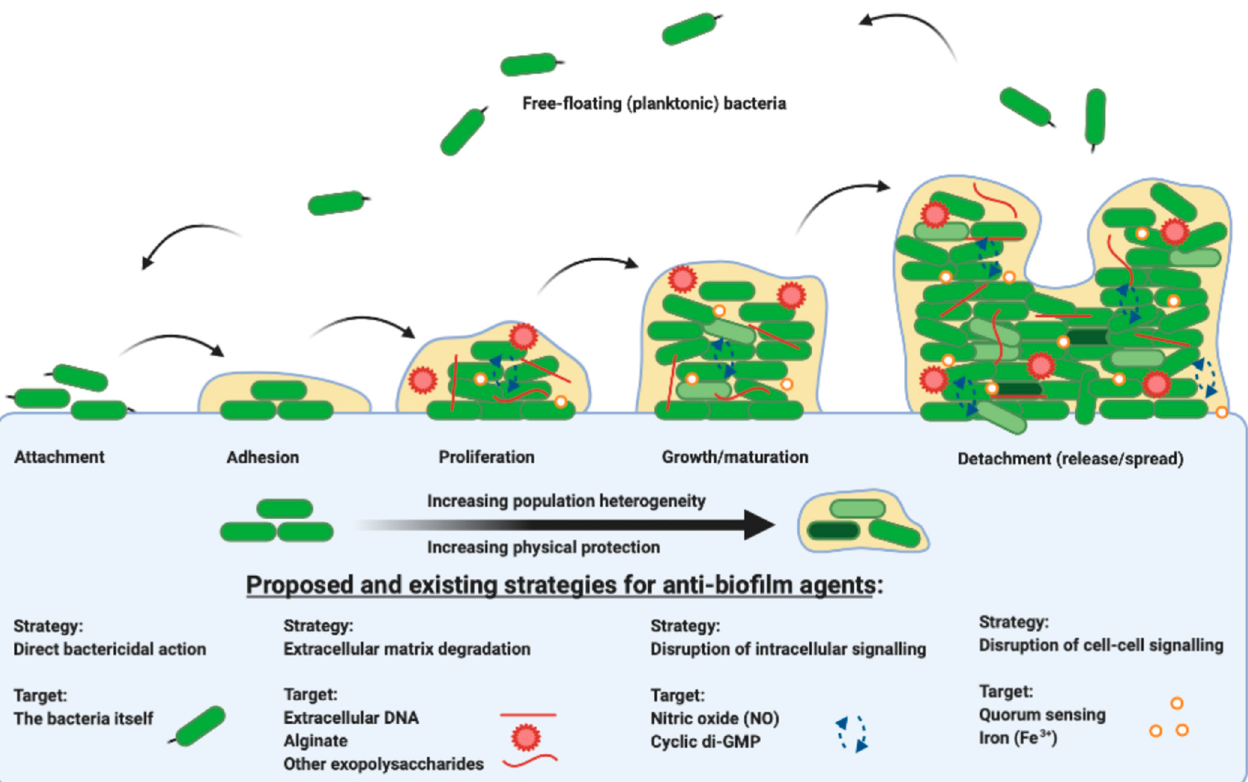
Figure 1. A representation of the bacterial biofilm life cycle, from the point at which free-floating planktonic cells attach to a substrate or surface, to adhesion, to proliferation and microcolony formation, through to growth and maturation and subsequent dispersal, propagating and beginning the life cycle once more. There are many existing and proposed strategies for targeting biofilm grown organisms, from direct action on the bacteria themselves, to the extracellular matrix, to intracellular signaling pathways, to the disruption of cell-to-cell signaling. Figure created in BioRender.com.